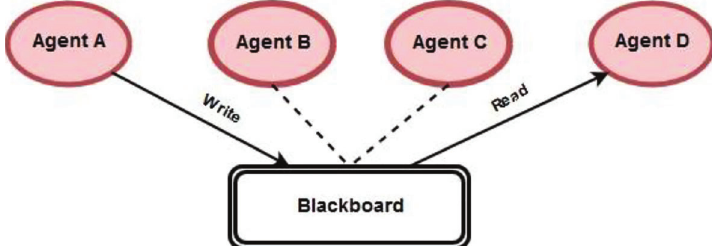
Figure 5. Schematic diagram of a simple black- board system in agent based